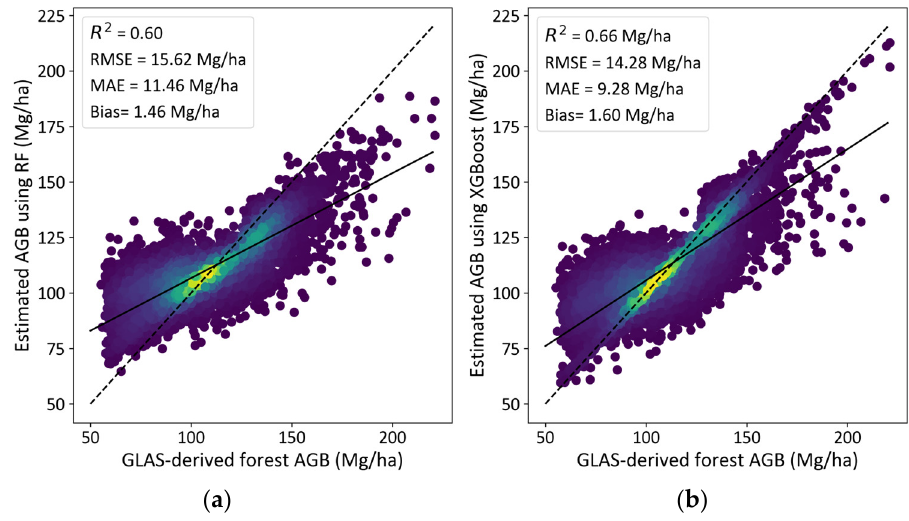
Figure 8. Density scatterplots of GLAS-derived forest AGB and predicted AGB using SHCE selected features from Landsat, PALSAR and DEM data using: ( a ) RF; and ( b ) XGBoost. The dashed line represents the 1:1 line.